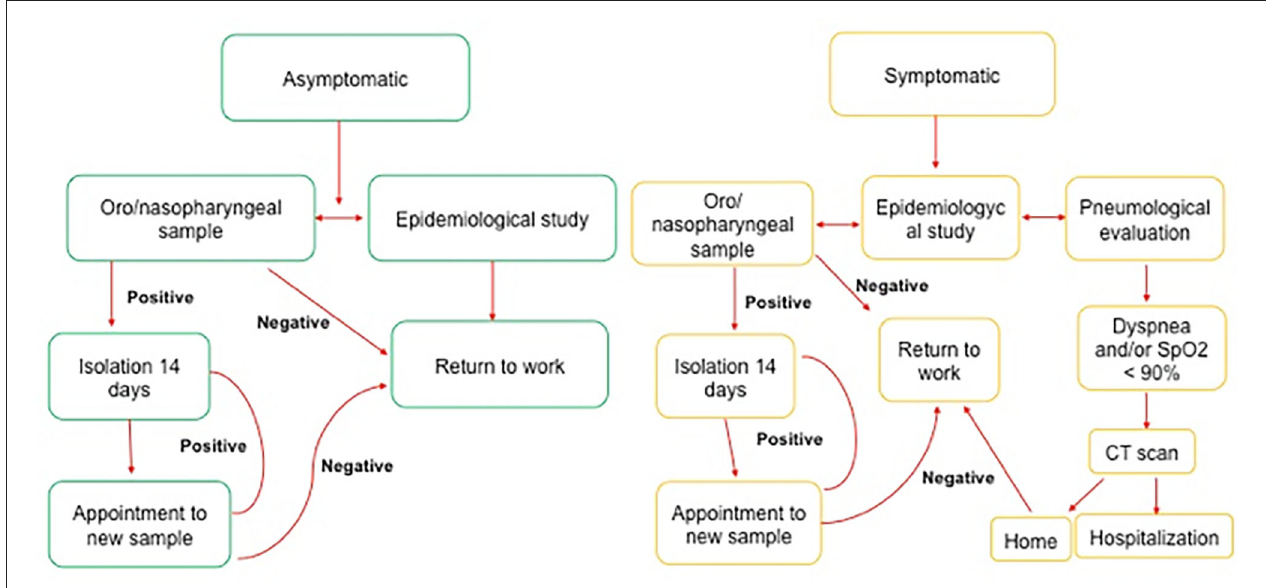
FIGURE 1 | Workflow followed in the INER for the implementation of the INER-POL-TRAB-COVID19